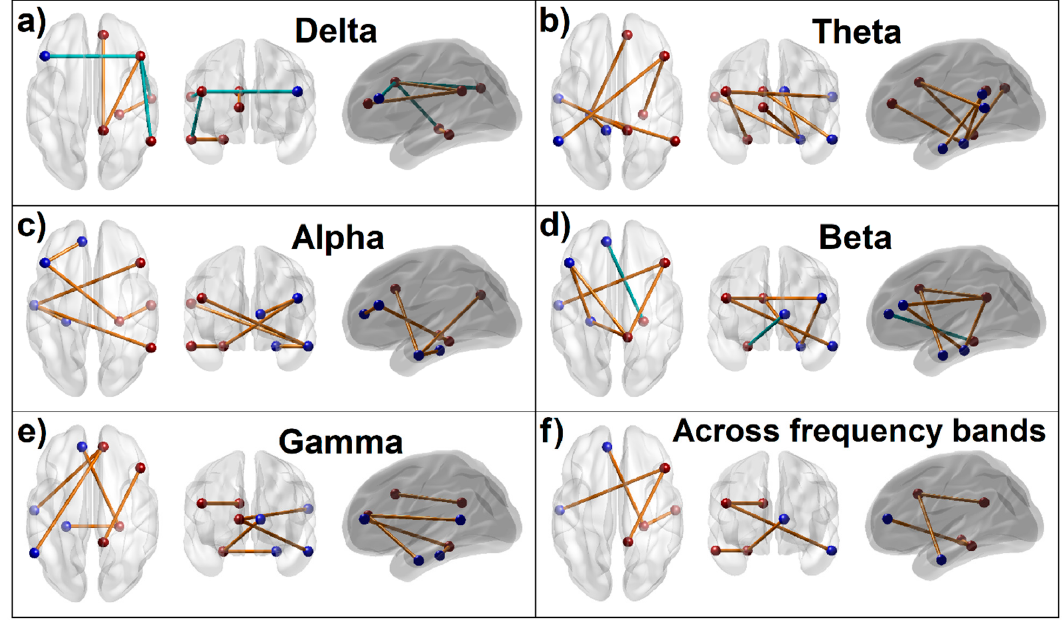
Figure 5. Panels (a – e): Significant default mode network (DMN) connections within each frequency band, which contributed to the Random Forest classification of alcohol use disorder (AUD) from control (CTL) individuals based on the importance parameters, viz., p -value ( p < 0.05), number of trees, and Gini index as listed in Table 3. Panel (f): Common connections across different frequency bands. The three images within each panel represent three views, respectively: axial or top view, coronal or front view, and sagittal or left view. The blue and red beads represent left and right-sided DMN nodes/seeds respectively, and the connections represented in orange/red and cyan/blue lines indicate hyper- and hypo-connectivity, respectively, in AUD compared to CTL group. Note that one of the four common connections, L.ACC – R.PHG, although shown here in orange/red (panel f), showed hypoconnectivity in beta band (panel d) and hyperconnectivity in gamma bands (panel e). A stricter threshold of p ≤ 0.001 restricted the number of significant connections to 12 (from